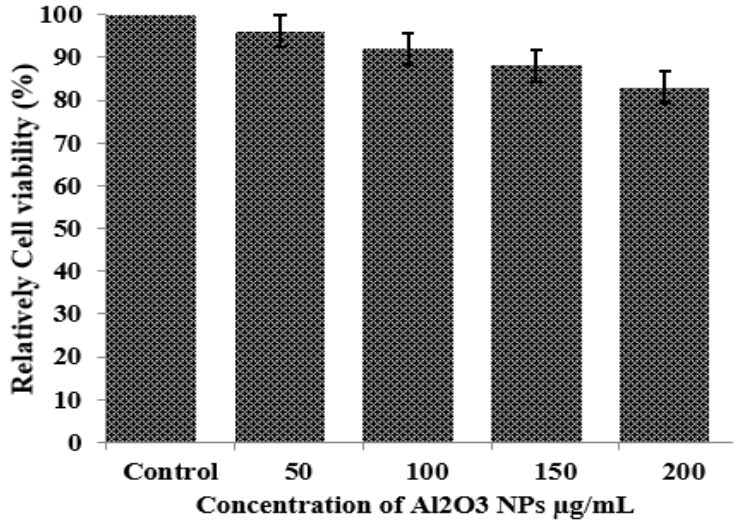
Figure 5: Showed the Vero cell lines treated with several doses of Al error was expressed for the data from three